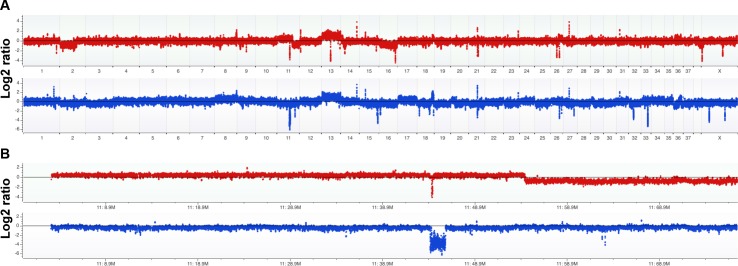
Comparative genomic hybridization analysis of canine BACA and CLAC lung adenocarcinoma cell lines.A custom 1M feature array was used to measure the DNA copy number across the genome relative to germline DNA from a normal dog. The zero line corresponds to a ratio of 1:1 between test DNA and a male reference DNA, or generally a copy number of 2. Gains are above the line and losses below. (A) Whole genome copy number analysis is shown with BACA on top (red) and CLAC on bottom (blue). Among the important findings, both cell lines have a 2-copy loss of CDKN2A/B/B-AS1 (encoding tumor suppressors p14-p19/ARF and p16/INK4; also shown in close-up in B panels) and a 2-copy gain of chr13 (which contains the oncogene MYC). Other large alterations are a 1-copy loss of most of chr2 and chr16 in BACA and a 1-copy gain and loss of chr17 and chr11, respectively in CLAC. Most of all other variants shared by the two cell lines represent Copy Number Variation (CNV) in the reference DNA. (B) Copy number analysis of complete chr11 shows BACA has a 1-copy gain over 2/3rds of its length and a 1-copy loss over the remainder and CLAC has a 1-copy loss over its full length. Both lines have a relatively small 2-copy loss (focal in BACA) that overlaps only CDKN2A/B/B-AS1 between the two cell lines.